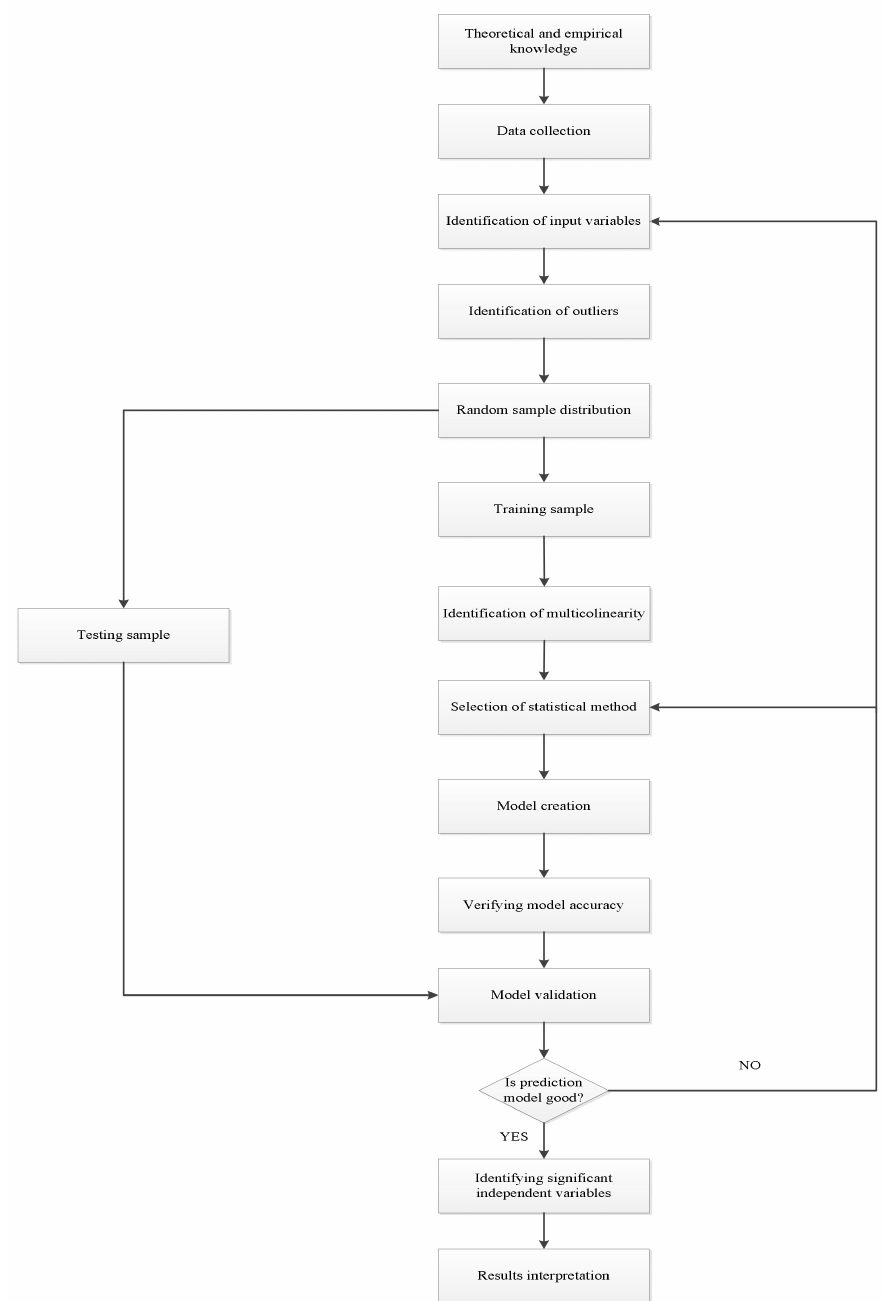
Figure 1. Algorithm for Prediction Model